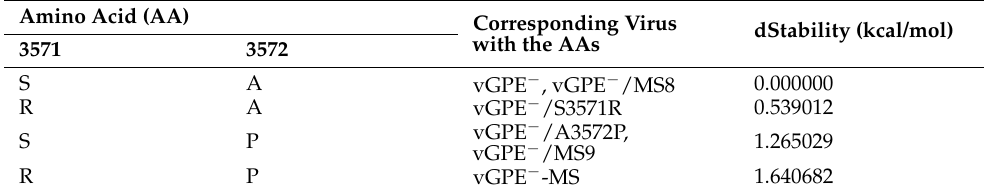
Figure 4. Effect of amino acid substitutions in NS5B on the viral RNA replication efficiency: ( a ) schematic diagrams of replicon genomes, coding firefly luciferase. The substituted amino acids are shown in red at positions 3571 and 3572 of NS5B; ( b ) the in vitro-transcribed replicon RNAs were electroporated into CPK cells. After 3 h, 12 h, 24 h, and 48 h of incubation, the firefly luciferase activity, expressed in relative light units, was assayed in cell lysates. The firefly luciferase activity was normalized with that of the replication-deficient rGPE − -N pro -Luc-IRES-NS3/GAA replicon at the initial time point. Each bar represents the mean value of the triplicates, with error bars showing the standard deviations. The significance of relative luciferase activity differences with replication-competent rGPE − -N pro -Luc-IRES-NS3 or replication-incompetent rGPE − -N pro -Luc-IRES-NS3/GAA was calculated with Student’s t -test. * indicates p < 0.05 compared with the rGPE − -N pro -Luc-IRES-NS3. # indicates p < 0.05 compared with the rGPE − -N pro -Luc-IRES-NS3/GAA. Table 1. Change of stability by amino acid substitutions with in silico mutagenesis calculation. Amino Acid